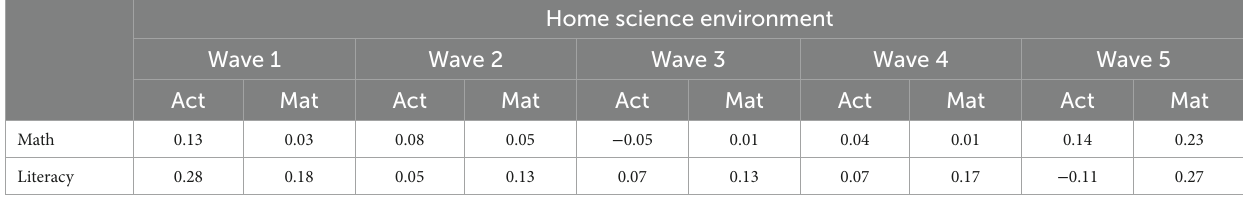
TABLE 13 Bivariate correlations for home science experience and math and literacy